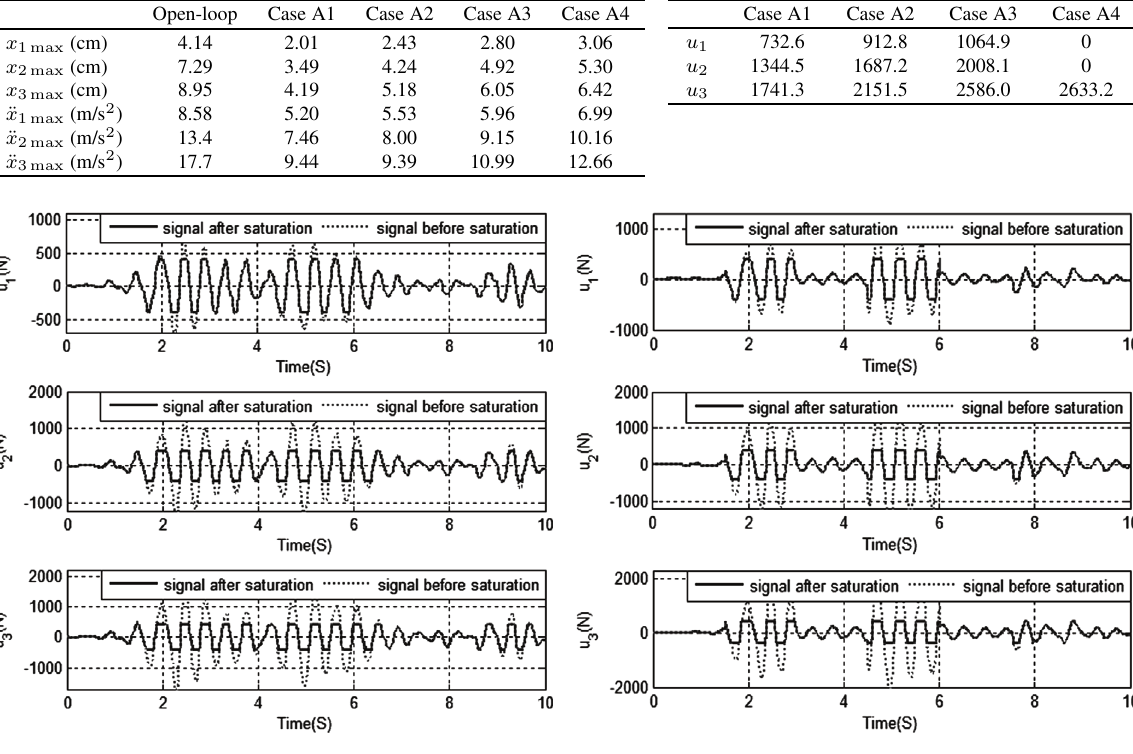
Fig. 6. Control forces in case A1 ( τ = 25 ms). Fig. 7. Control forces in case A2 ( τ = 25